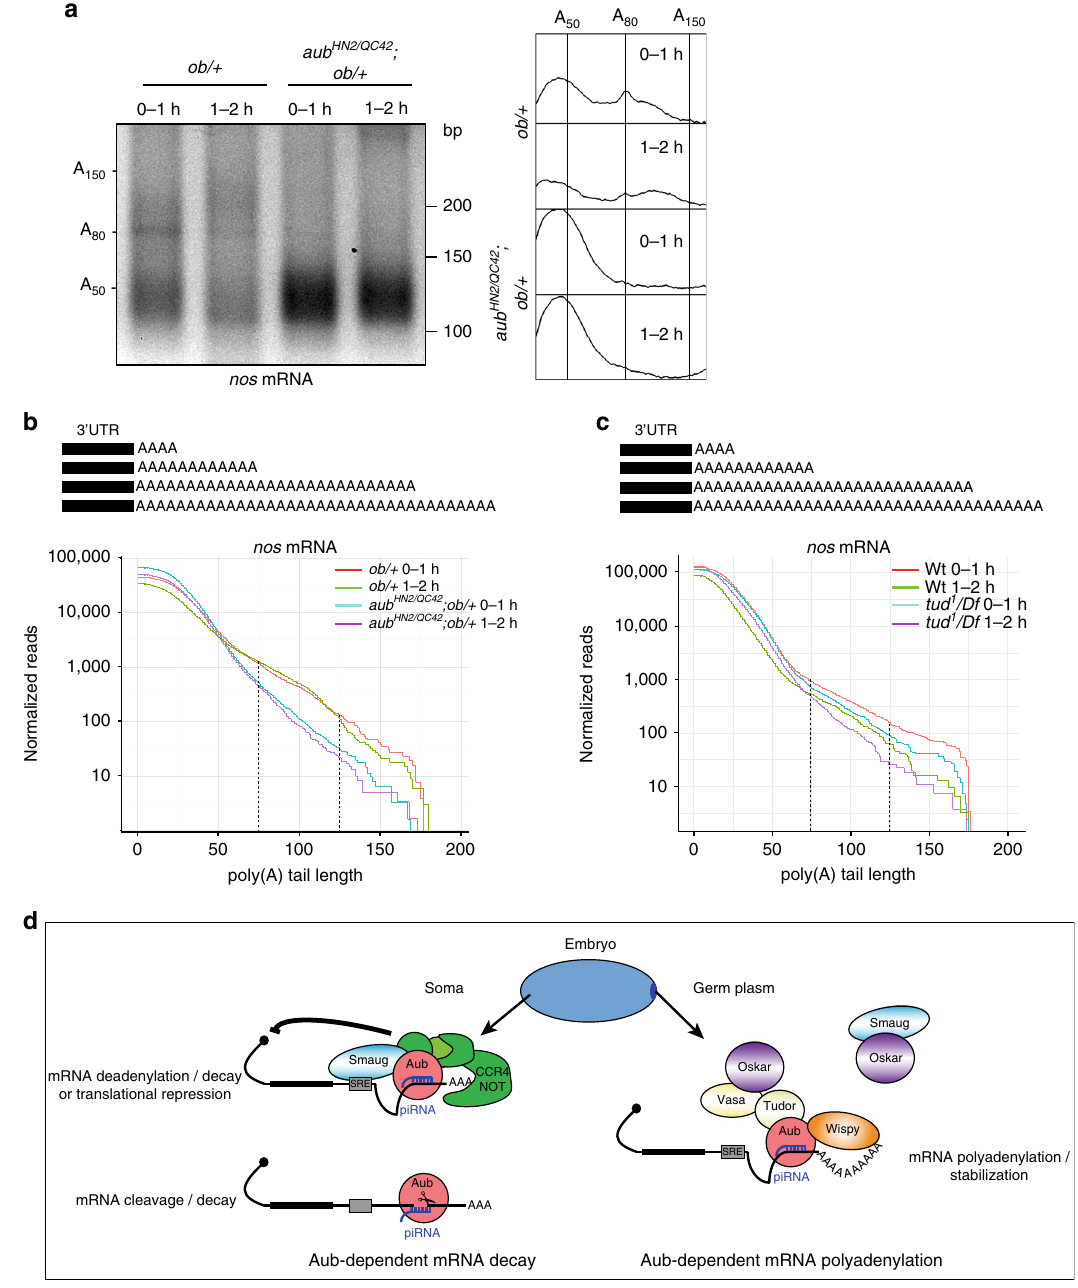
Fig. 5 Aub recruits Wisp to stabilize germ cell mRNAs in the germ plasm. a ePAT assays of nos mRNA in 0 – 1 h- and 1 – 2 h- ob/ + embryos, in wild-type and aub mutant backgrounds. ePAT assay pro fi les using ImageJ are shown on the right. b , c Distribution of sequenced nos mRNA poly(A) tails in ob/ + and aub − ; ob/ + mutant embryos ( b ), and in wild-type and tud mutant embryos ( c ). Each curve represents the mean of two biological replicates normalized to reads per million. The mPAT reads are displayed as cumulative plots: all reads having at least a speci fi c number of non-templated A-bases are pooled, as shown in the scheme (top panel). The x -axis represents the number of non-templated A-bases sequenced at the end of each read and the y -axis represents the normalized number of reads on a log scale. The portion of the graph corresponding to the pool of nos mRNA with long poly(A) tails is indicated with broken lines. In b , the proportion of reads having 100 A-bases or more (% of total) is signi fi cantly reduced in the aub mutant ( p = 0.0025) by two-way ANOVA, which takes into consideration both time and genotype variables. d Model of the dual function of piRNA-loaded Aub in maternal mRNA somatic decay and stabilization in the germ plasm. See text for Immunoresearch, 115-166-006); anti-mouse Alexa 647-conjugated (Invitrogen, A- mouse anti-Aub (4D10) 48 1:800; rabbit anti-Aub (Abcam, ab17724) 1:100; mouse 21236); anti-guinea pig Cyanine 3-conjugated (Jackson Immunoresearch, 706-165- anti-Armi 49 1:500; mouse anti-Wispy (7B3, a gift from N. Kim) 1:100; guinea pig 148)) were used at dilution 1:500. For whole-mount in situ hybridization experi- anti-Smg 50 1:1000; and rabbit anti-CCR4 51 1:200. Secondary antibodies (anti- ments, fi xed embryos were rehydrated gradually with methanol-PBT-Tween (PBS rabbit Alexa 488-conjugated (Invitrogen, A-11034); anti-mouse Alexa 488- supplemented with 0.1% Tween-20) and washed three times in PBT-Tween. conjugated (Invitrogen, A-11029); anti-rabbit Cyanine 3-conjugated (Jackson Embryos were prehybridized in pre-warm HB buffer (50% formamide, 5× SSC, 50 Immunoresearch, 711-165-148); anti-mouse Cyanine 3-conjugated (Jackson